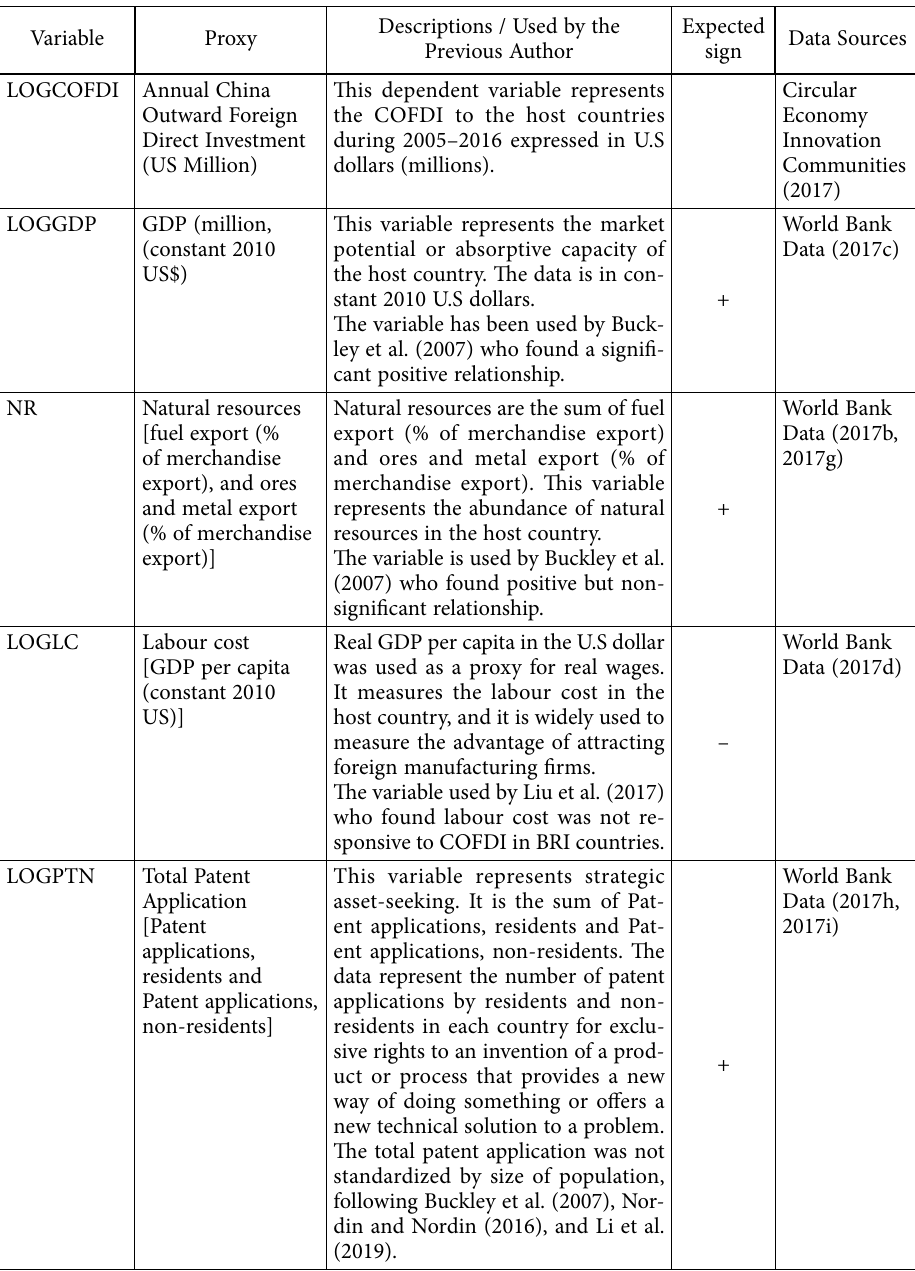
Table 1. Determinants of Chinese OFDI